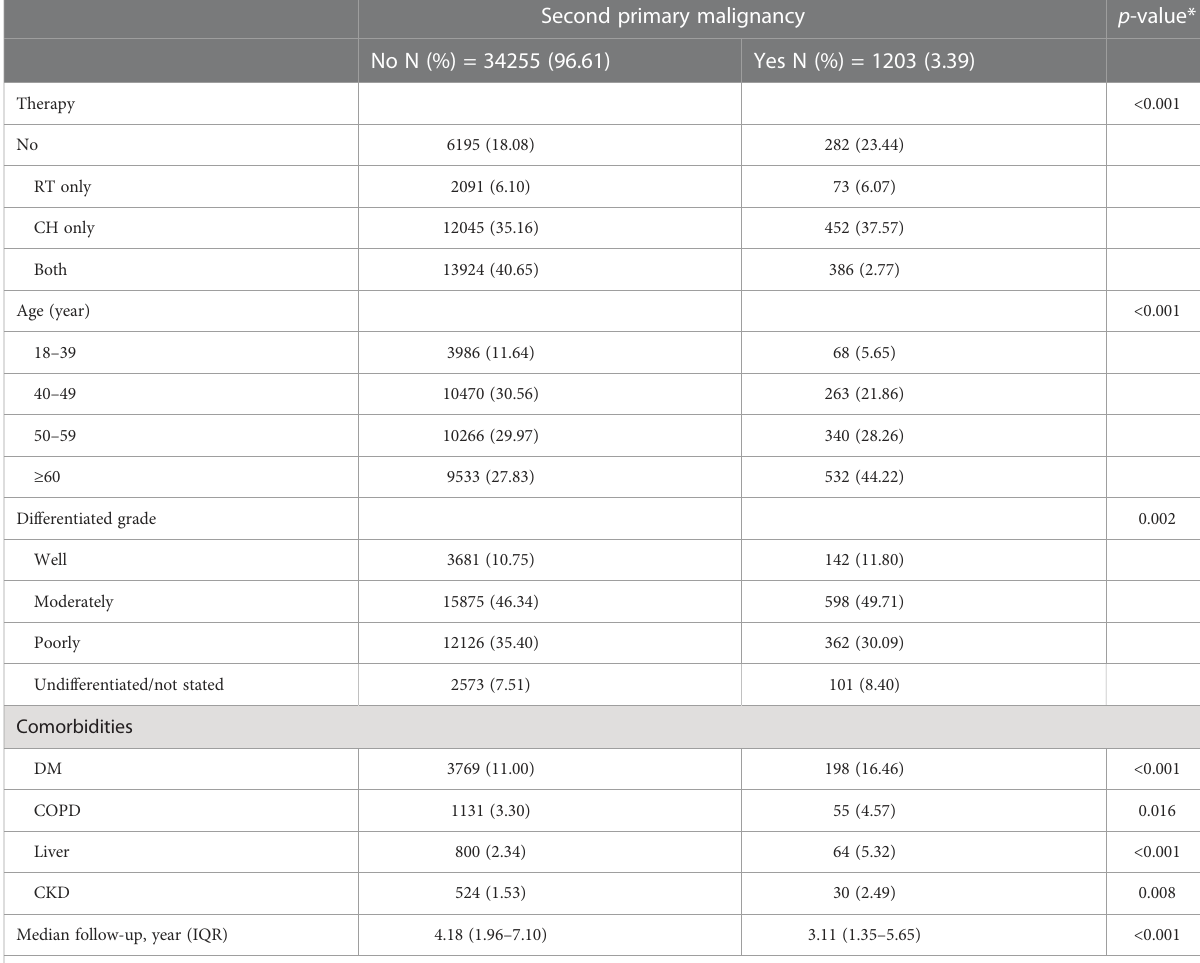
TABLE 4B Risk of second primary malignancies in patients with stage II breast